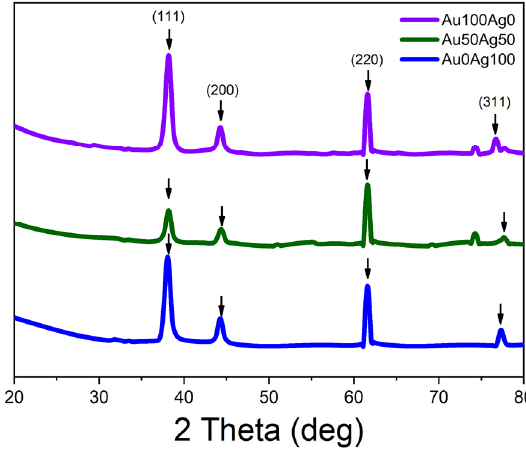
Figure 3. The XRD pattern of Au-Ag nanoalloys.